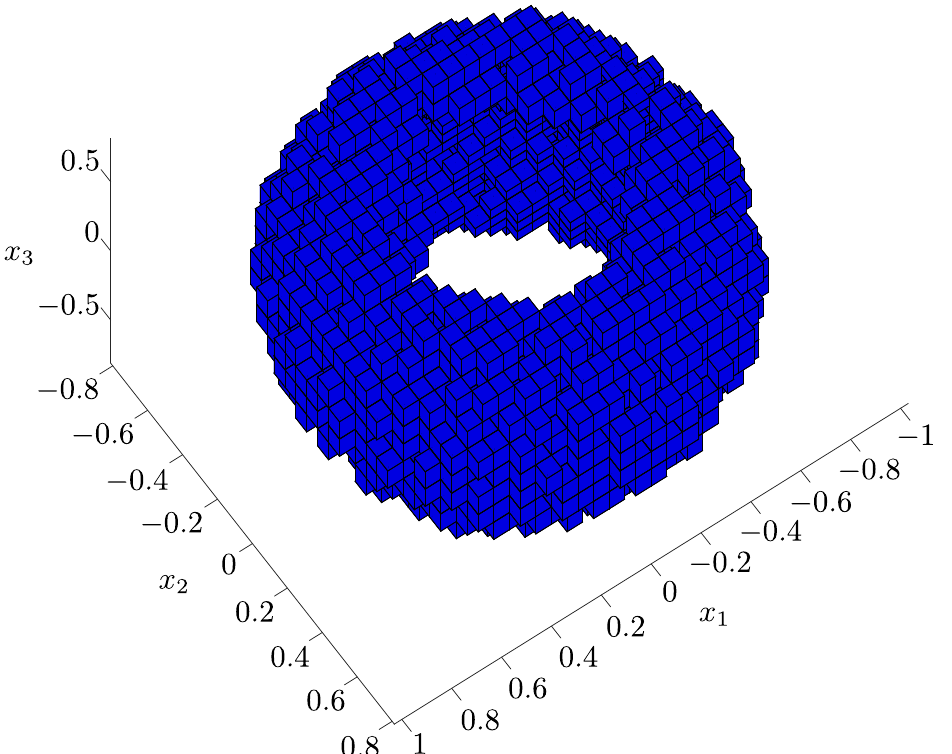
Figure 2. Illustration of all indistinguishable intervals for the interval (27) after 10,000 iterations for the nonlinear system